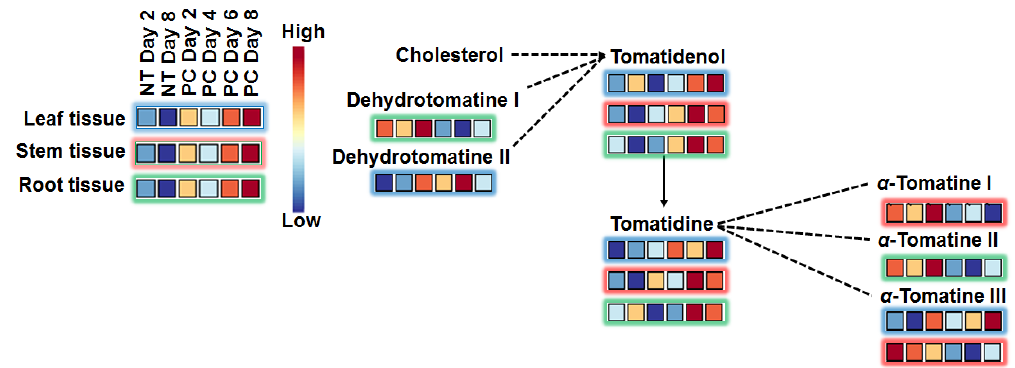
Figure 7. Metabolic changes in glycoalkaloid pathway in Phytophthora capsici -infected tomato tissues over the time-period of 2–8 d.p.i. Selected metabolites (VIP score ≥ 0.5) in infected plants were compared to those in control plants at the given time point. Blue boxes indicate down regulated metabolites/associated with the control, while red boxes indicate up regulated metabolites/associated with the treatment. Solid lines with an arrow indicate a single reaction, dotted lines with an arrow indicate multiple reactions, and dotted lines with no arrows indicate conjugation. NT = non-treated and PC = P. capsici (stem - inoculated).